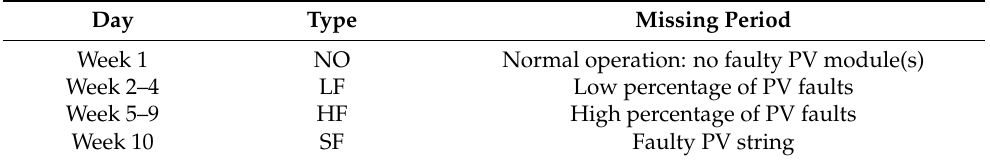
Table 1. Considered PV conditions.